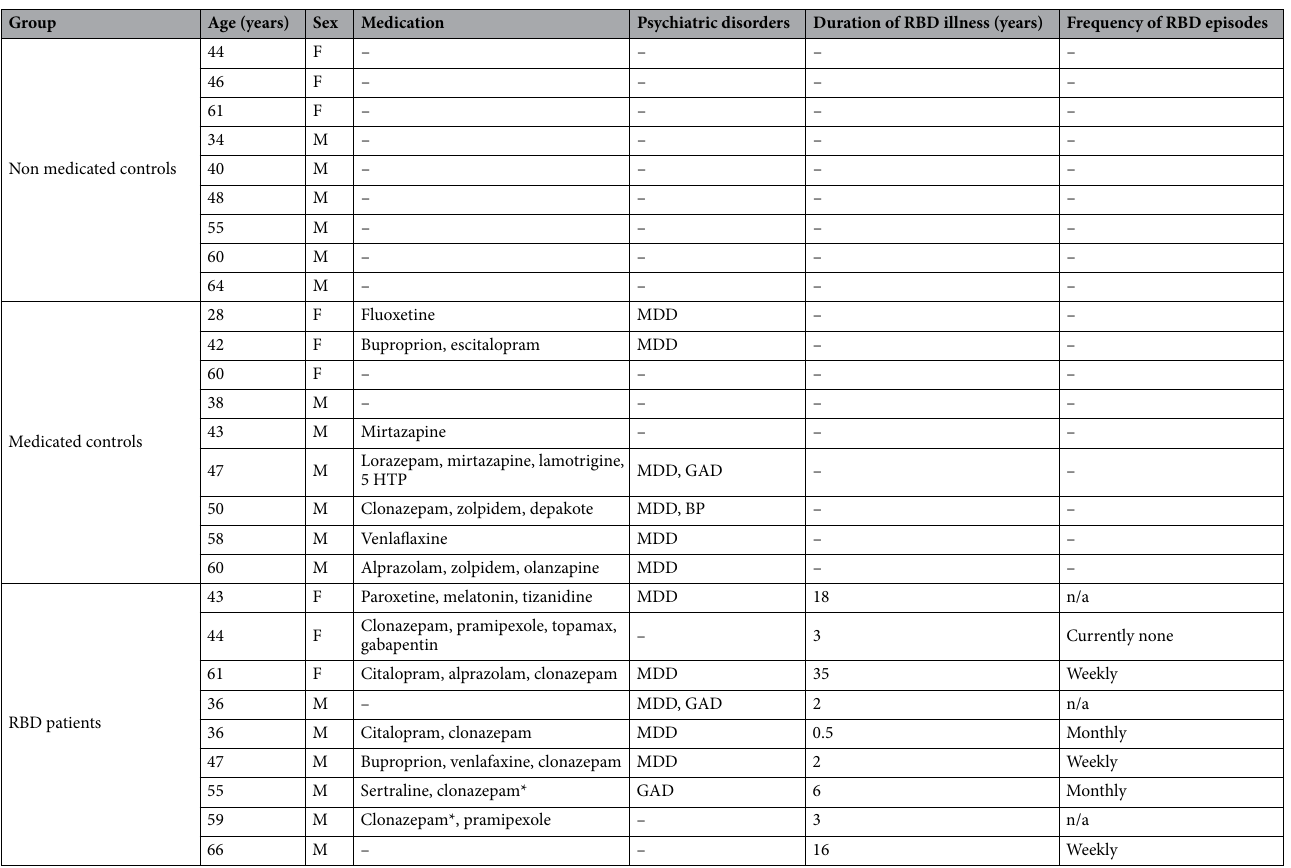
Table 1. Medical details of the participants. The duration of illness for RBD patients began when symptoms were first noticed. The frequency of episodes ranged from a few times per week to a few times per month. One participant on clonazepam was not having episodes at the time of their study. n/a indicates that the frequency could not be precisely determined because of an absence of a bed partner or because of a vague medical description (such as “chronically acts out dreams”). *Indicates that clonazepam was tapered before the sleep study. The list of indicated medication includes any antidepressants, benzodiazepines, anticonvulsants or other CNS drugs, and excludes opioids, anti-hypertensives, corticosteroids, asthma medication or hormones. 5 HTP, serotonin; BP, bipolar disorder; GAD, general anxiety disorder; MDD, major depressive disorder. The medicated control group and RBD patients were not statistically different with regard to the occurrence of GAD, MDD, and the use of antidepressants, benzodiazepines, anticonvulsants and non-benzodiazepine hypnotics (Fisher’s exact tests: all p >